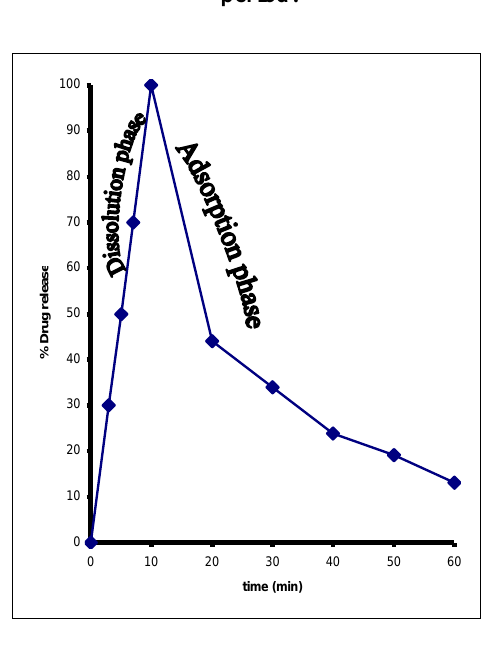
Figure 2: The percent of alpha-tocopherol acetate released from magnesium carbonate adsorbent at pH 1.2 before incubation period.